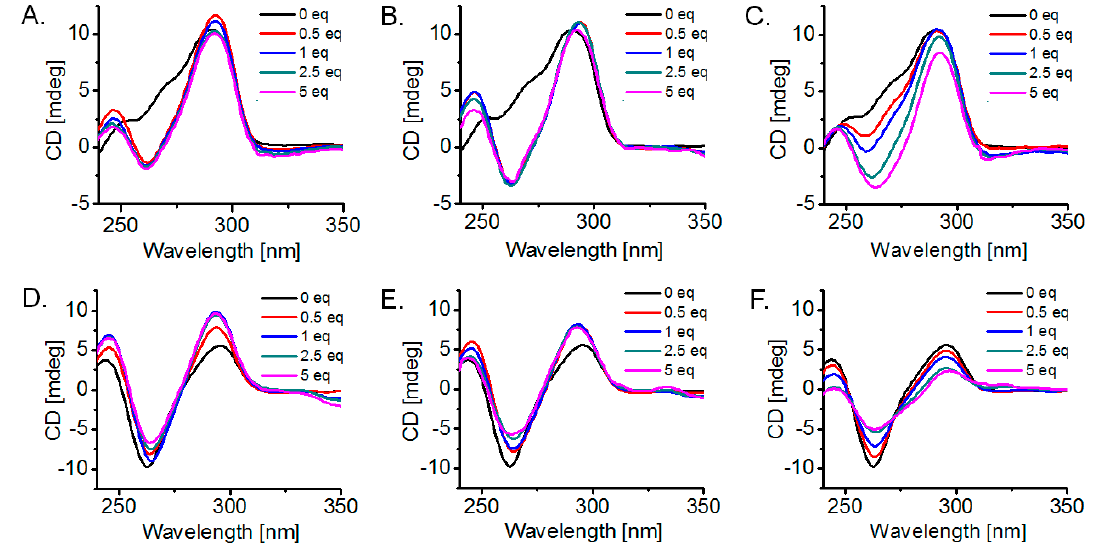
Figure 5. Circular dichroism (CD) titrations of 3 µM prefolded 22AG G-quadruplexes with increasing amounts (0–5 equivalents) of tested ligand: ( A – C ). DNA in 10 mM lithium cacodylate buffer (pH = 7.2) with 100 mM KCl, compounds 14 , 13 and 10 , respectively; ( D – F ). DNA in 10 mM lithium cacodylate buffer (pH = 7.2) with 100 mM NaCl, compounds 14 , 13 and 10 , respectively.